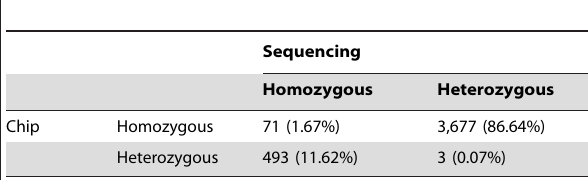
Table 2. Patterns of chip-discordance in concordant SNVs between